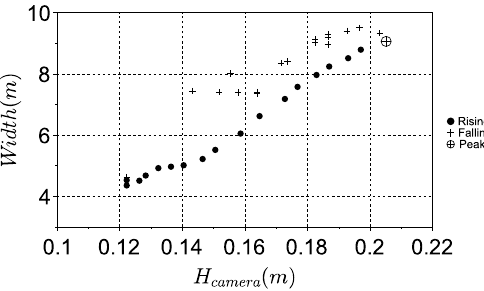
Figure 15. The water surface width as a function of water stage, for falling flows ( + ), rising flows ( • ) and the discharge peak ( ⊕ ). The graph shows that for a given water level ( H camera ) the water surface is wider with falling flow than with rising flow conditions. The end of the falling flows usually happens at night; therefore, the data are